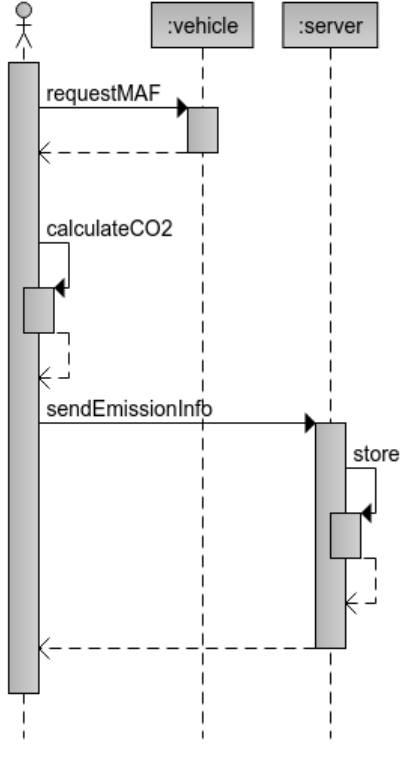
Figure 2. System communication